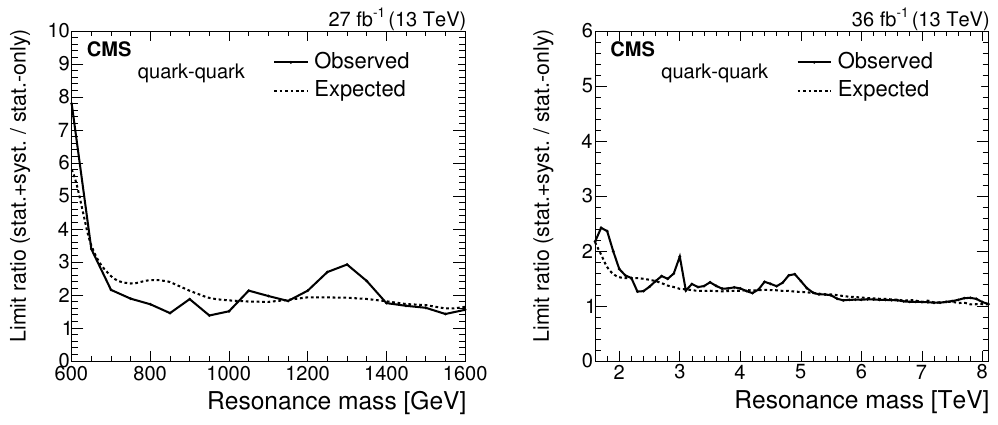
Figure 10 . The observed (points) and expected (dashed) ratio between the 95% CL limit on the cross section, including systematic uncertainties, and the limit including statistical uncertainties only for dijet resonances decaying to quark-quark in the low-mass search (left) and in the high- mass search